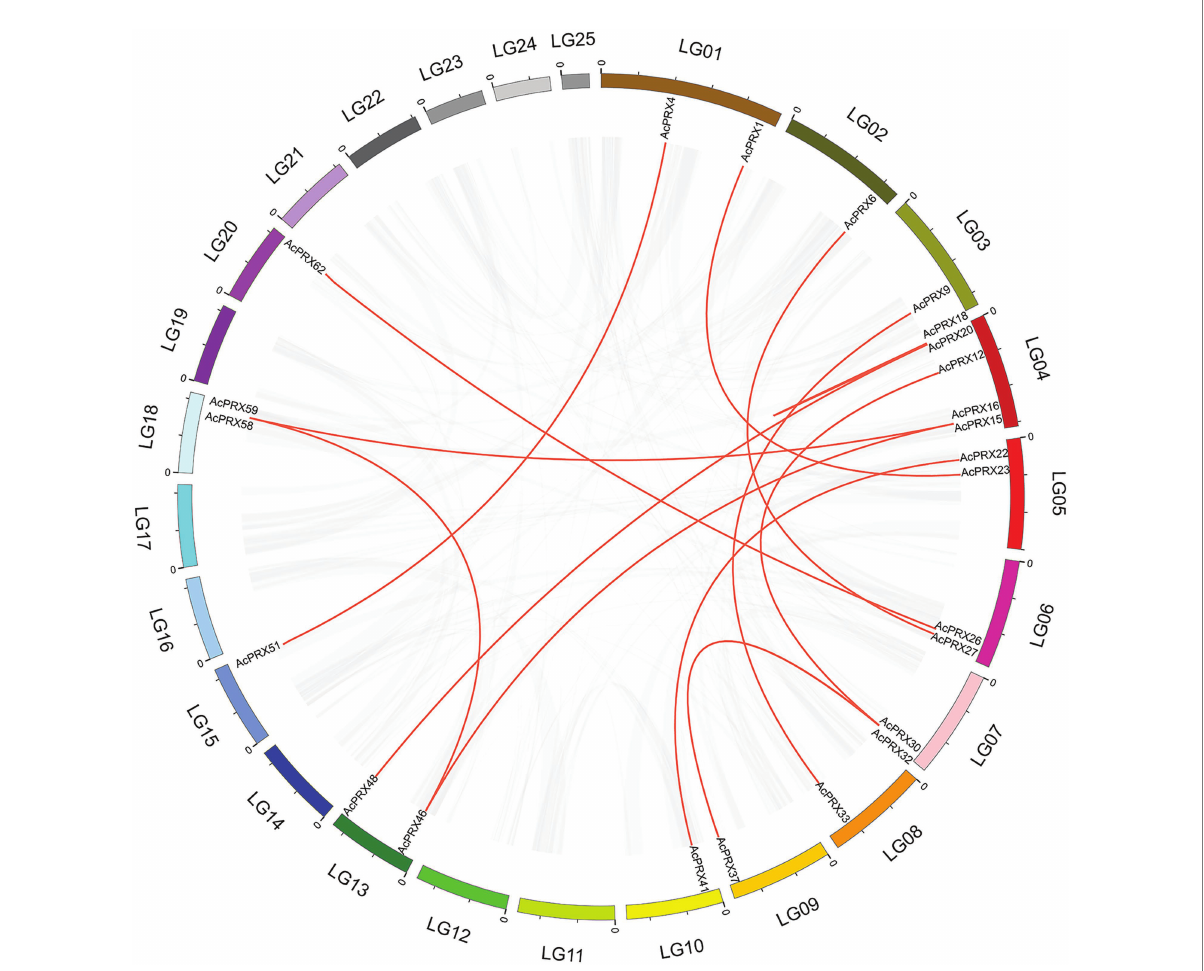
FIGURE 7 Analysis of gene duplication events leading to extant AcPRXs . All synteny blocks are represented by grey lines, and duplicated PRX gene pairs are connected by red